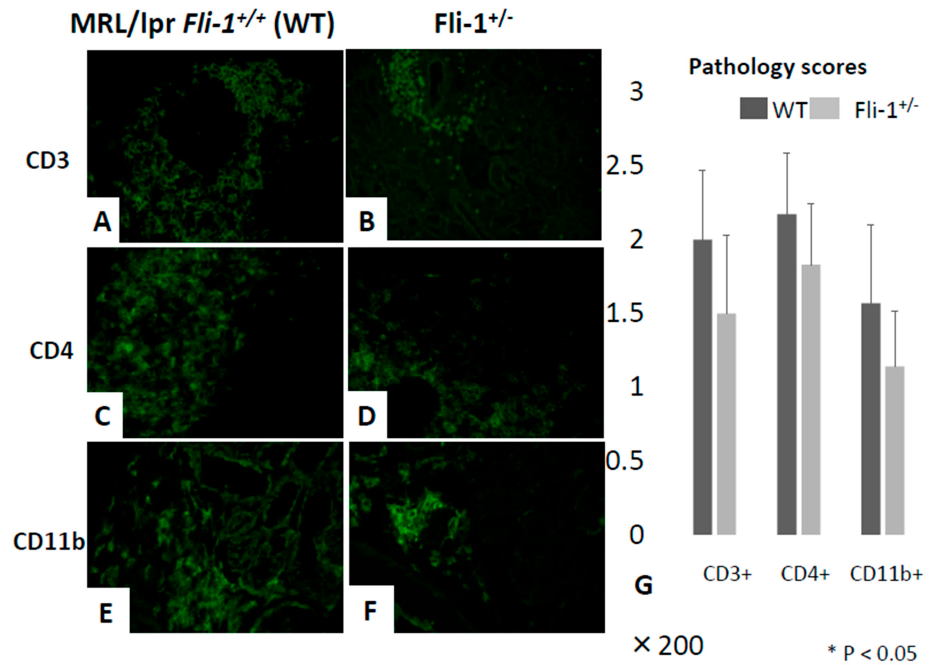
Figure 5. Relative infiltration of CD3 + , CD4 + , and CD11b + immune cells in the kidney of MRL / lpr Fli-1 +/+ (WT) and MRL / lpr Fli-1 +/ − mice using FITC-conjugated anti-CD3, CD4, and CD11b antibodies. The grade of CD3 + ( A , B ), CD4 + ( C , D ), and CD11b + ( E , F ) immune cell infiltration from WT MRL / lpr and MRL / lpr Fli-1 +/ − mice is shown ( n = 6–10 per groups). Pathology scores of each group are shown ( G ); * p < 0.05 is considered as significant.